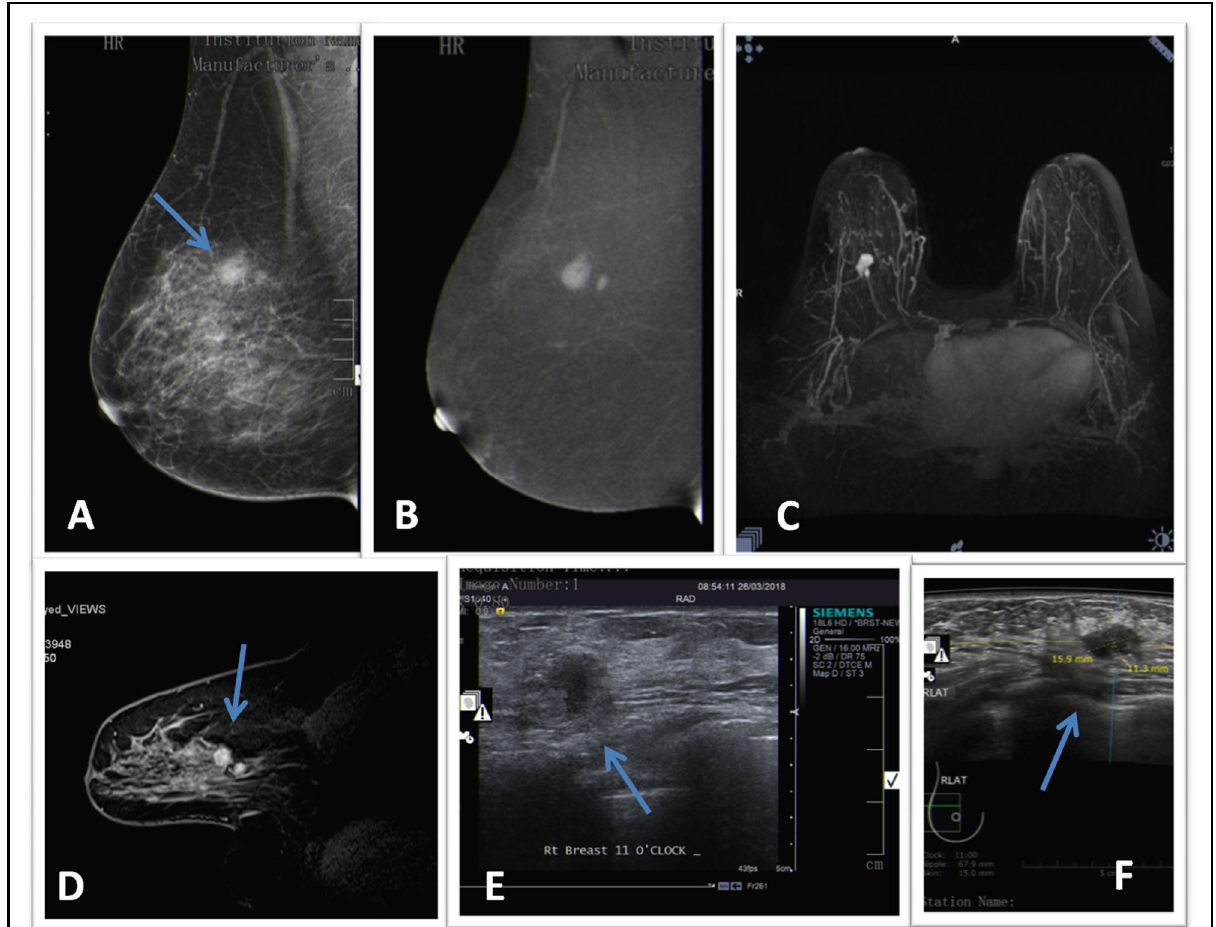
Fig. 4 A 44-year-old lady presenting with an enlarging right breast lump. a Rt. MLO digital mammogram shows UOQ nodule within glandular tissue. b Recombined CESM clearly shows two homogenously enhancing well defined nodules (avid enhancement) within a non-enhancing background. c DCE-MRI-MIP image shows the enhancing lesion within the breast with an adjacent vessel. d Delayed DCE sagittal MRI shows the two enhancing nodules within a glandular breast parenchyma. e , f 2D HHUS and 3D ABUS respectively shows a single complex cystic lesion. Pathology revealed: invasive ductal carcinoma grade